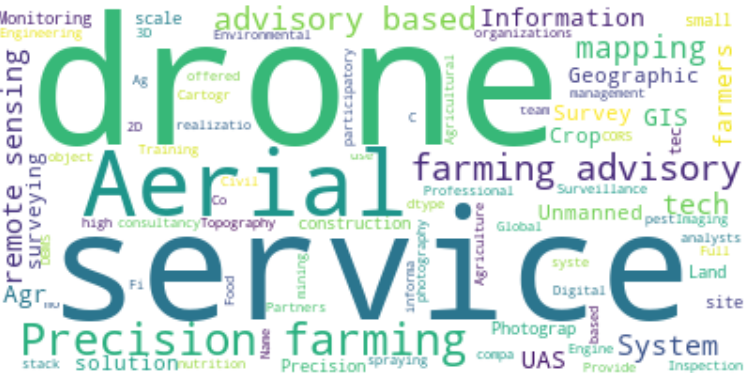
Figure 1. Word cloud of the descriptions of services by members of Africa Goes Digital.